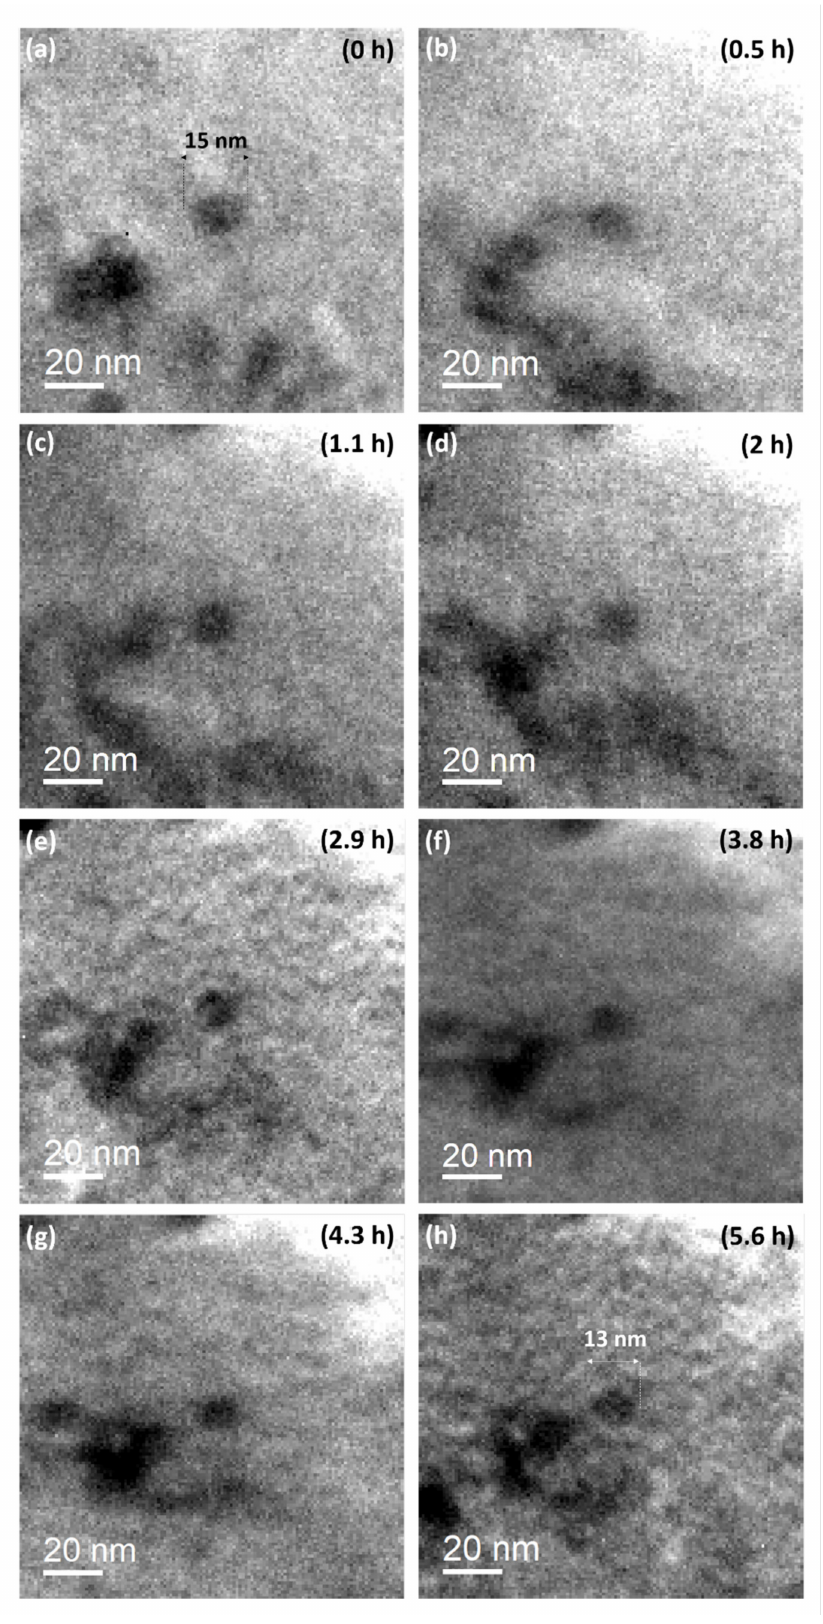
Figure 10. In situ observation of the evolution of a nano-oxide during 4 MeV Au 2+ irradiation: ( a ) before irradiation, ( b ) after 0.5 h (1.3 dpa), ( c ) after 1.1 h (3 dpa), ( d ) after 2 h (5 dpa), ( e ) after 2.9 h (8 dpa), ( f ) after 3.8 h (10 dpa), ( g ) after 4.3 h (12 dpa), and ( h ) after 5.6 h (15